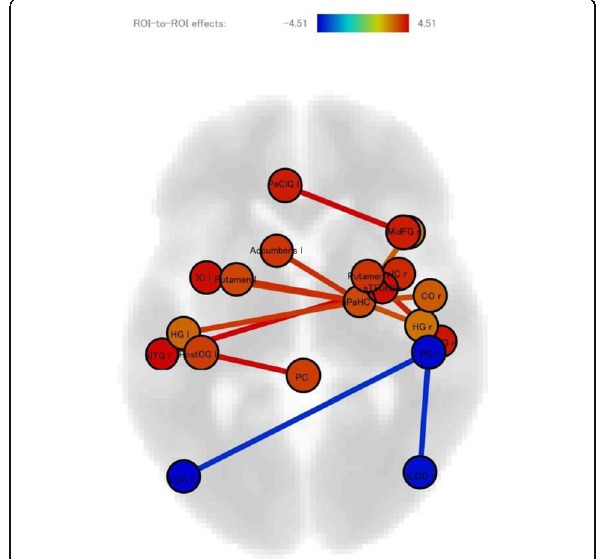
Fig. 1 (abstract P66). See text for description.